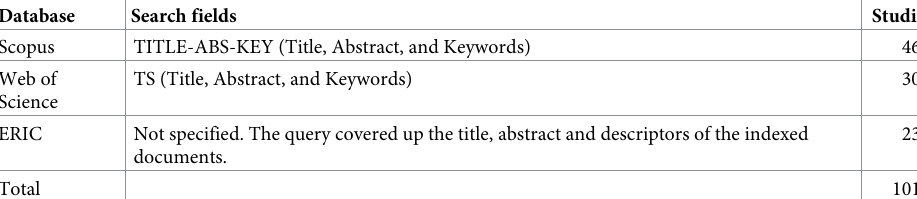
Table 3. Results of the search in the considered